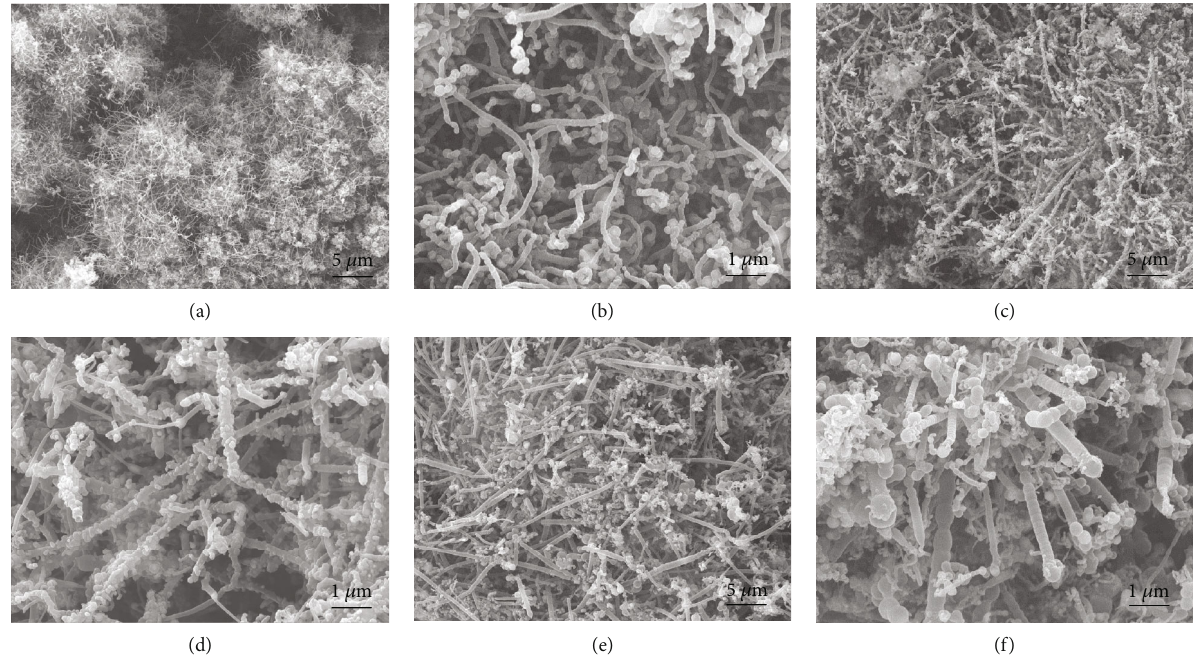
Figure 1: SEM images of CNTs synthesized by Ppy NFs and ferrocene under microwave radiation for 30 s (a, b), 60 s (c, d), and 90 s (e, f).